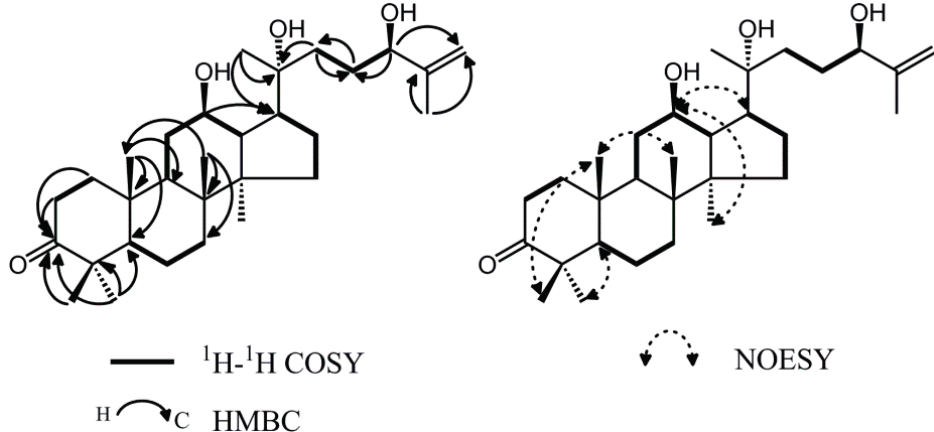
Figure 2. Key 1 H- 1 H COSY, HMBC and NOESY correlations of 6